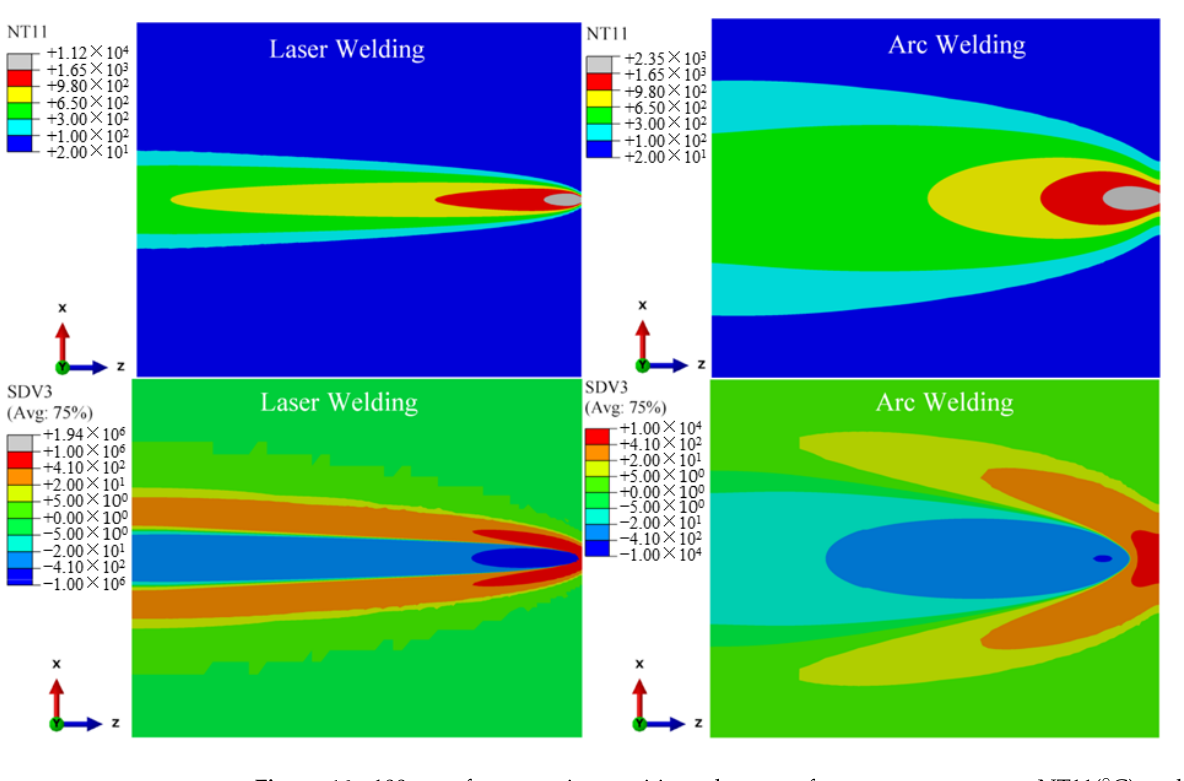
Figure 15. 25 mm from starting position, changes of current temperature NT11( °C ) and cooling/heat- ing rate SDV3( °C /s) during welding.